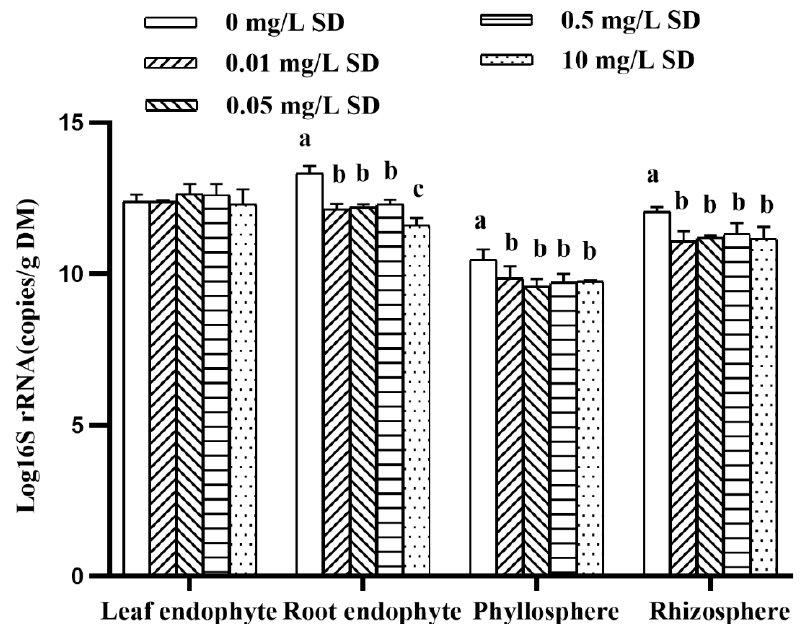
Figure 3. Effects of SD concentration on the log 16S rRNA absolute abundance in different parts of lettuce. Error bars represent standard deviations of the means. a, b, and c on top of the error bars represent significant differences ( p < 0.05) among different initial concentrations of treatments.